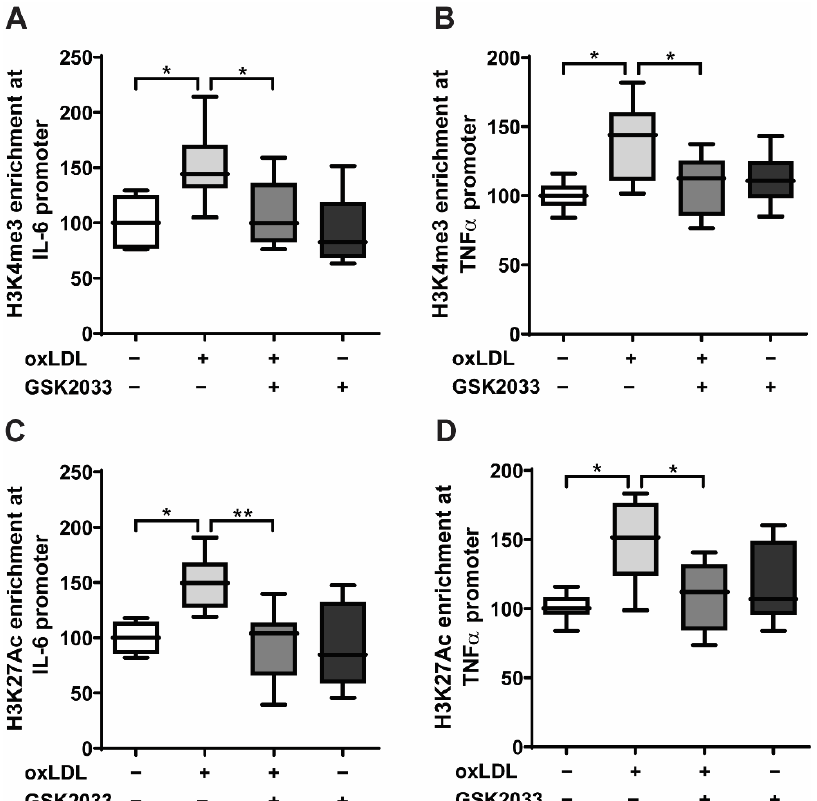
Figure 3. LXR inhibition inhibits epigenetic reprogramming. Monocytes were treated as indicated with 20 µg/mL oxLDL, 2.5 µM GSK2033 (LXR antagonist), or vehicle for 24 h and kept for 5 days in a complete medium. Chromatin was collected and a ChIP-PCR assay was performed using an antibody against histone H3 acetylated at lysine 27 (H3K27ac), histone H3 trimethylated at lysine 3 (H3K4me3), or control IgG. Then, quantitative real-time PCR was performed with primers for IL-6 ( A , C ) and TNFα ( B , D ). Graphs represent mean values ± SD of six individuals in three different experiments. * p < 0.05 and ** p < 0.01.